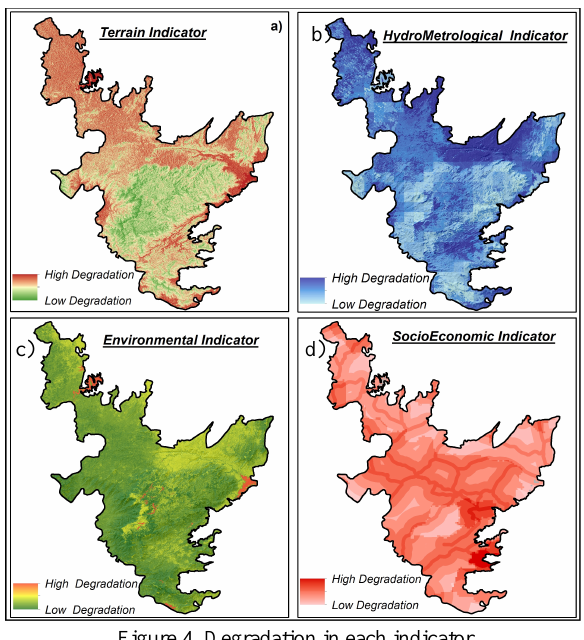
Figure 4. Degradation in each